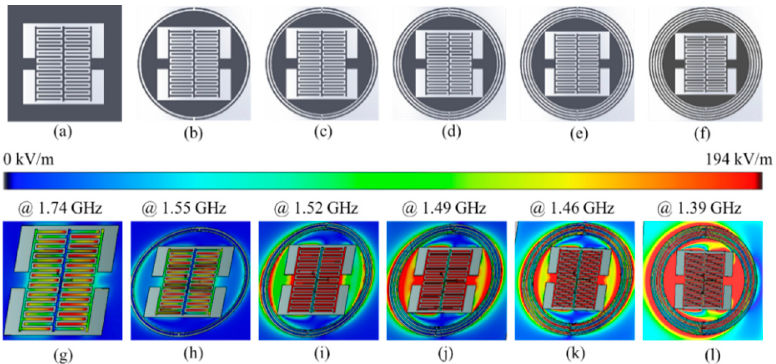
Figure 6. Proposed microwave sensor with e-field distribution at the lower tunable resonant fre- quency; ( a ) designed sensor without a circular finger; ( b ) with one circular finger; ( c ) with two circular fingers and one bridge-type structure; ( d ) with three circular fingers and two bridge-type structure; ( e ) with four circular fingers and three bridge-type structure; ( f ) with five circular fingers and four bridge-type structure; ( g ) e-field at 1.74 GHz; ( h ) 1.55 GHz; ( i ) 1.52 GHz; ( j ) 1.49 GHz; ( k ) 1.46 GHz; and ( l ) 1.38 GHz.